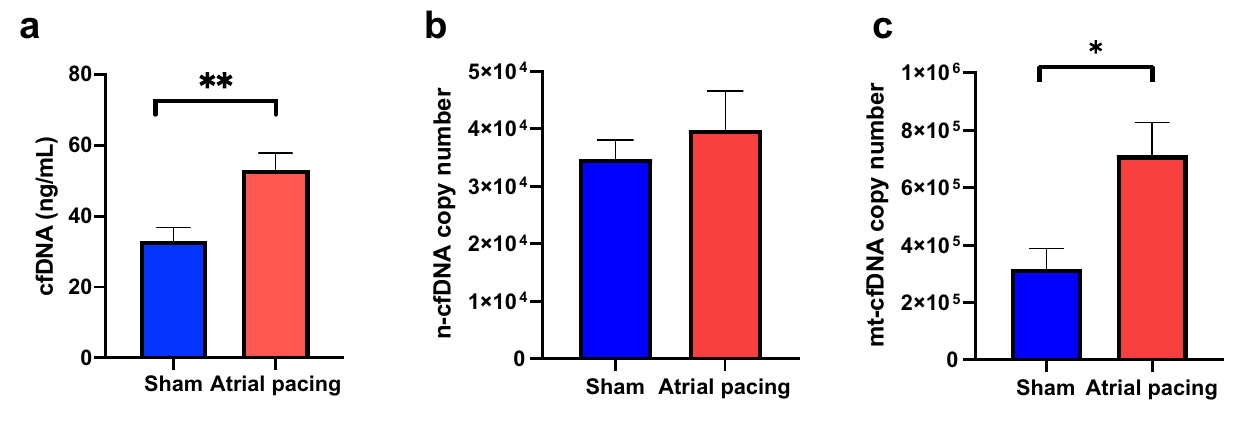
Figure 4. Total cfDNA, n-cfDNA, and mt-cfDNA in an in vivo AF mimicking model. ( a ) Total cfDNA, ( b ) n-cfDNA copy number, ( c ) mt-cfDNA copy number in an in vivo tachycardia pacing model (n = 7). Absolute n-cfDNA and mt-cfDNA copy number were calculated using qPCR using the created standard curves. * p < 0.05.